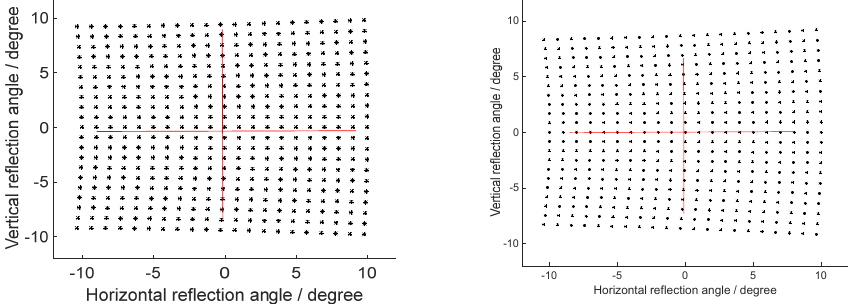
Figure 6. The reflection angle at the different incident angles (the incident angle of the left is 20 ° ; the incident angle of the right is 30 ° ).